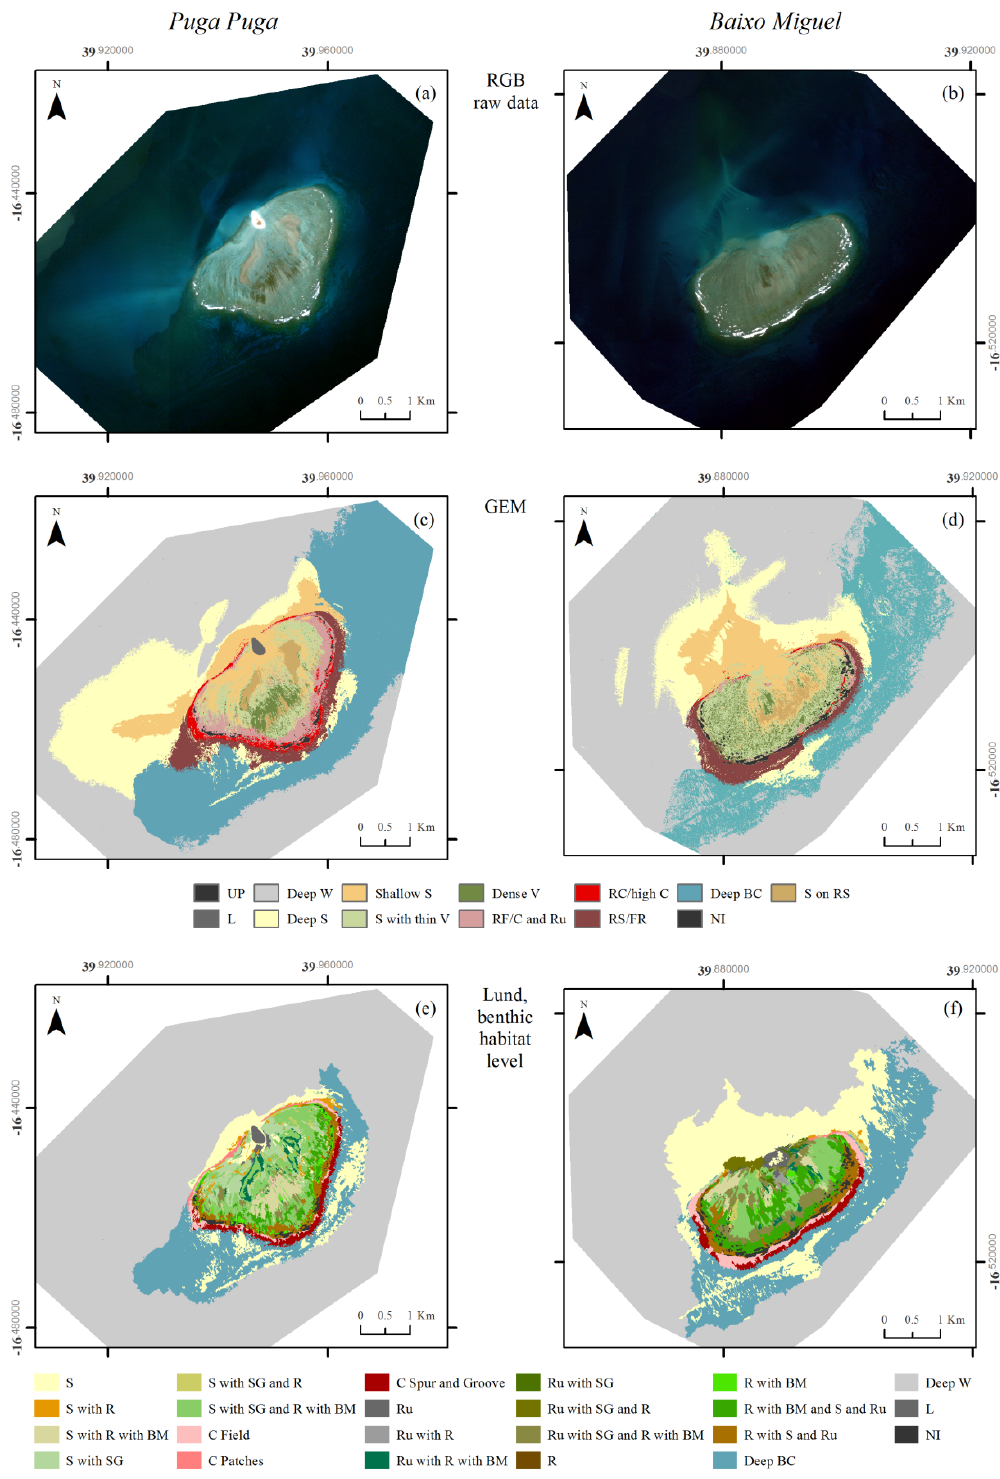
Figure 3. Example of ( a , b ) raw data (min and max percentage clip = 0.2); ( c , d ) GEM and ( e , f ) Lund mapping results for PugaPuga and Baixo Miguel; BC = benthic cover, BM = brown macroalgae, C = coral, FR = fore reef, L = land, NI = No information, R = rock(s), RC = reef crest, RF = reef front, RS = reef slope, Ru = rubble, S = sand, SG = seagrass, UP=unprocessed,V = vegetation, W = water.